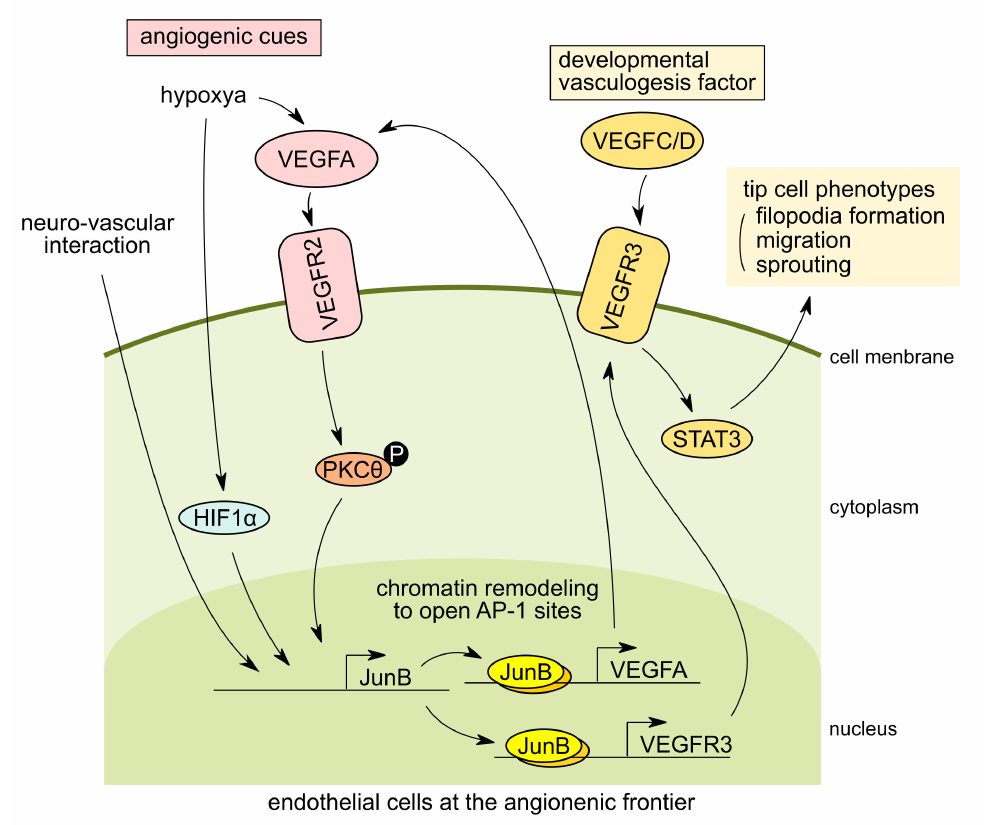
Figure 2. Tip cell phenotype expression in response to angiogenic cues in endothelial cells at the vasculogenesis frontier. In endothelial cells at the angiogenesis frontier during vascular development, JunB expression is induced by angiogenic cues including hypoxia and vascular endothelial growth factor A (VEGFA) through hypoxia-inducible factor 1 subunit alpha (HIF1 α ) or phosphorylation of protein kinase C theta (PKC θ ). “P” indicates phosphorylation of the molecule. (left). In the developing skin vasculatures, the direct interaction of endothelial cells with peripheral neurons can also stimulate JunB expression and coordinate neurovascular parallel alignment (left). In tip cells, JunB is involved in the upregulation of vascular endothelial growth factor receptor 3 (VEGFR3) expression which is a key VEGFR for angiogenesis at specific developmental stages. VEGFR3 binds vascular endothelial growth factor C and D (VEGFC/D), while signaling cascades are required for tip cell migration and sprouting of endothelial cells by signal transducer and activator of transcription 3 (STAT3) activation at the angiogenic frontier (right). The arrows indicate the relationship of signaling